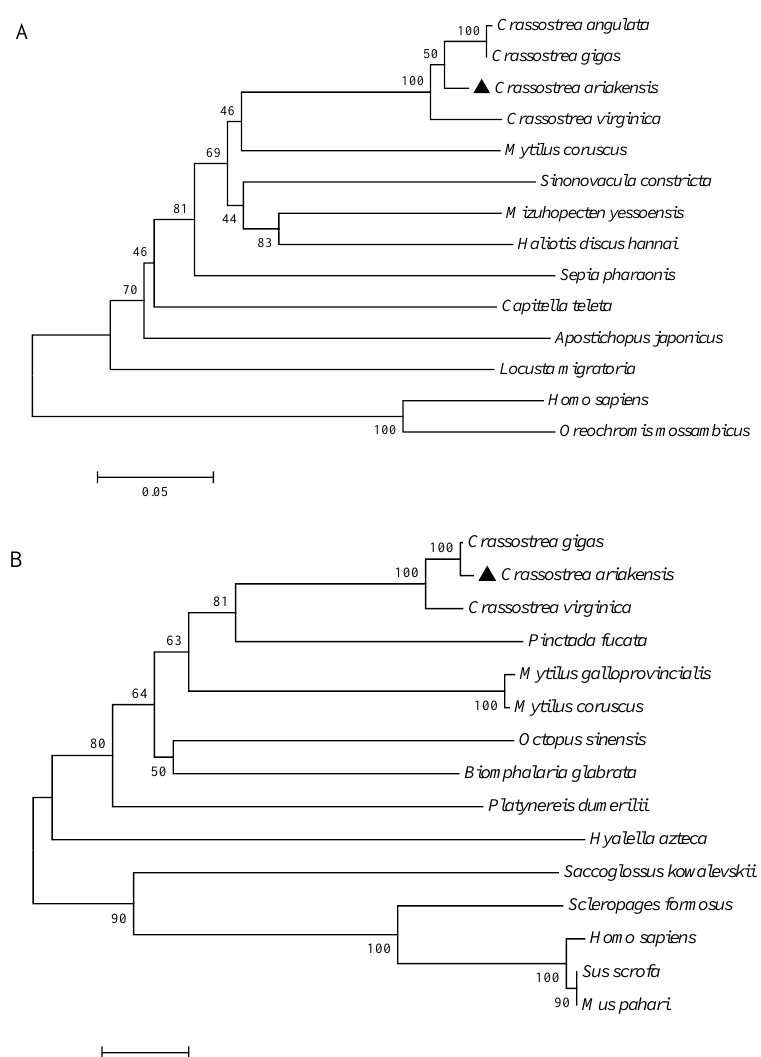
Figure 1. Phylogenetic analysis of GYS and GSK3β in different species. GenBank IDs in ( A ): Crassostrea angulate (CCN27372.1); Crassostrea gigas (XP_034316496.1); Crassostrea virginica (XP_022340936.1); Mytilus coruscus (CAC5409044.1); Sinonovacula constricta (QLQ34388.1); Mizuhopecten yessoensis (XP_021358473.1); Haliotis discus hannai (BBI18978.1); Sepia pharaonis (CAE1228952.1); Capitella teleta (ELT91212.1); Apostichopus japonicus (PIK54210.1); Locusta migratoria (ACM78946.1); Homo sapiens (NP_002094.2); Oreochromis mossambicus (ABU62630.1). GenBank IDs in ( B ): Crassostrea gigas (XP_011452760.1); Crassostrea virginica (XP_022323945.1); Pinctada fucata (AKJ32474.1); Mytilus galloprovincialis (VDI08035.1); Mytilus coruscus (CAC5393303.1); Octopus sinensis (XP_02963674-3.1); Biomphalaria glabrata (XP_013066809.1); Saccoglossus kowalevskii (NP_001158498.1); Platynereis dumer- ilii (ANS60440.1); Scleropages formosus (KPP62668.1); Sus scrofa (NP_001121915.1); Hyalella azteca (XP_018012954.1); Homo sapiens (NP_002084.2); Mus pahari